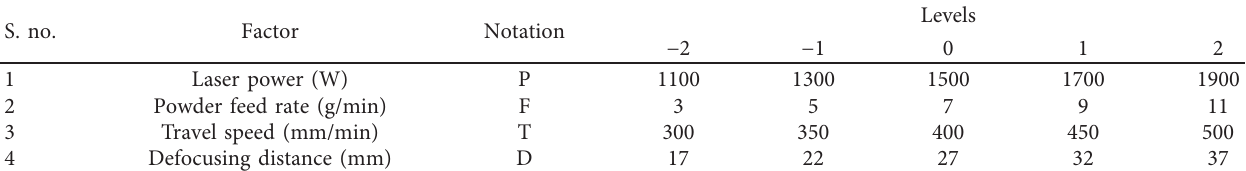
Table 2: Laser hard-faced processessing parameters and their working range. S.